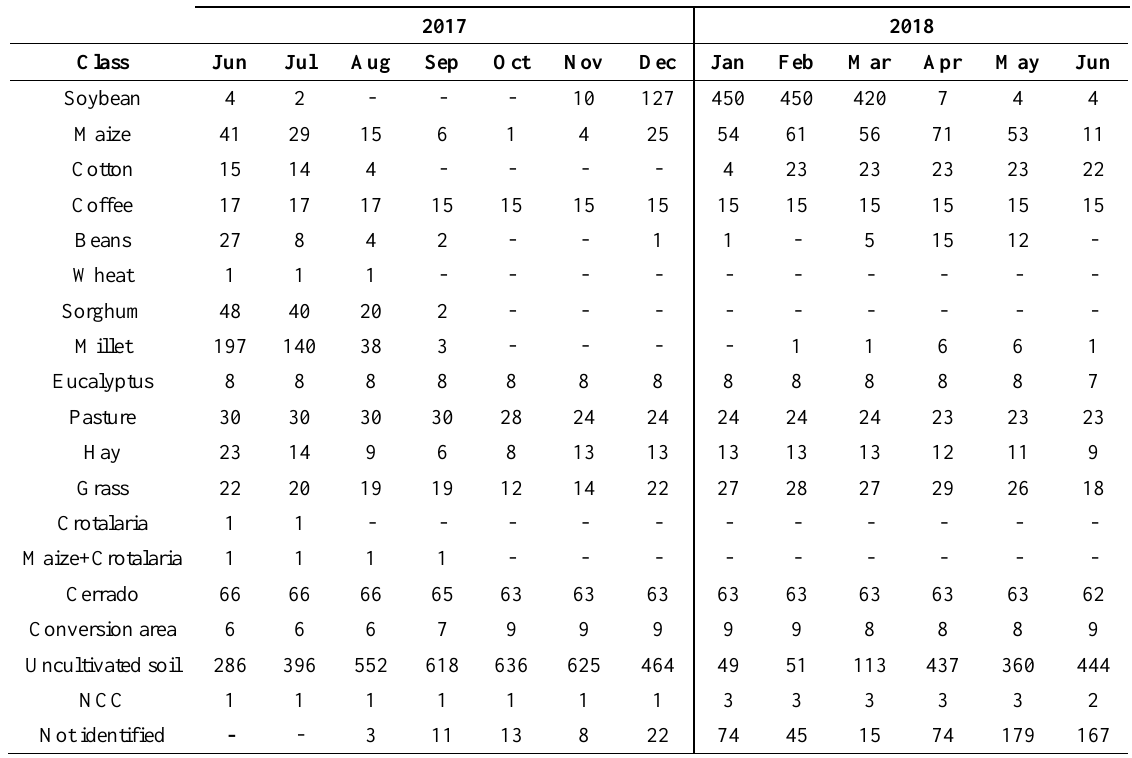
Table 3. Number of fields per class in each epoch.